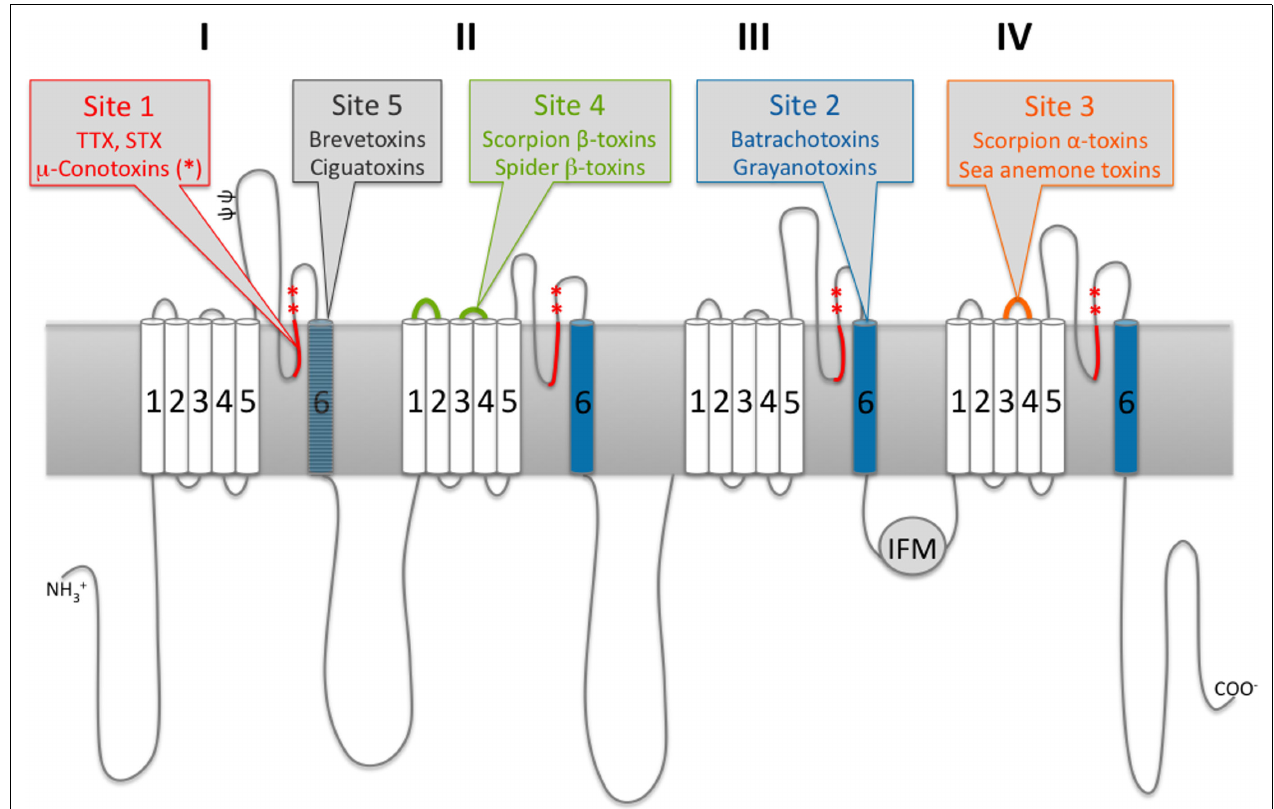
FIGURE 1 | Schematic two-dimensional representation of the functional α -subunit of voltage-gated ion channels and identification of known neurotoxin binding